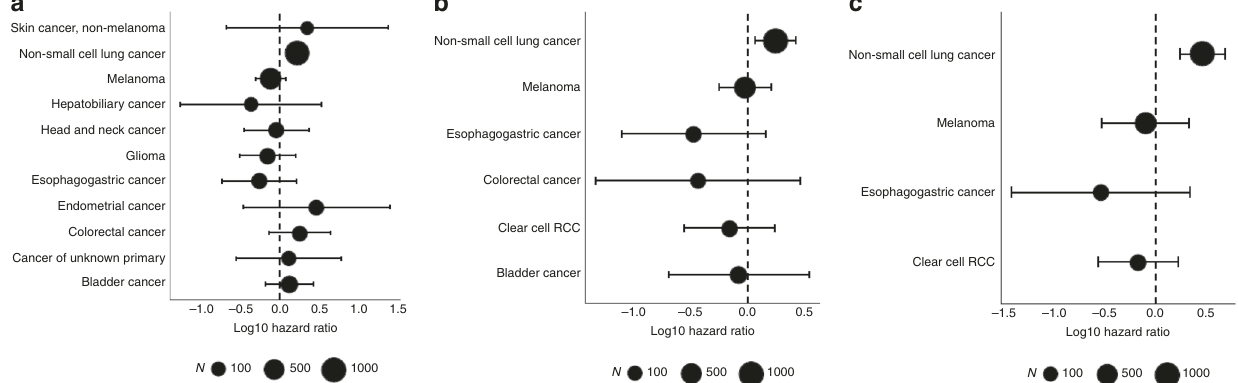
Fig. 6 Forest plots of overall survival by PBRM1 or ARID2 loss. Forest plots demonstrating hazard of death in ICB-treated patients examining a PBRM1 or ARID2 LOF + non-LOF mutations, b PBRM1 or ARID2 LOF mutations alone, and c PBRM1 LOF mutations alone. Error bars represent 95% con fi dence